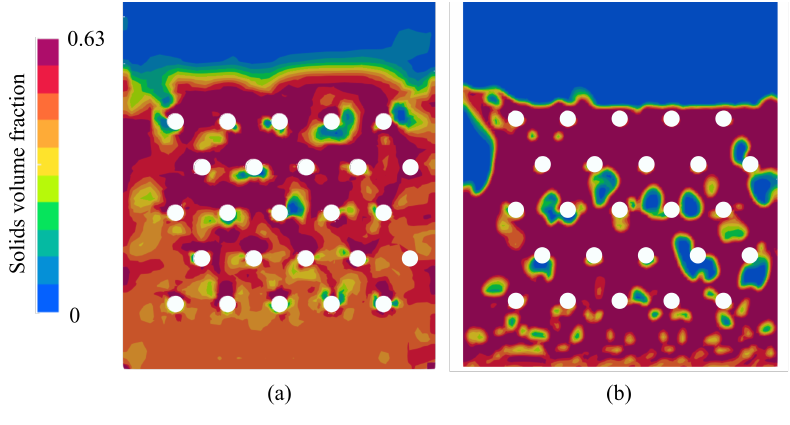
Figure 9. Solids fraction distribution in a mid-vertical cutting plane using OpenFOAM ( a ) and MFiX ( b ).